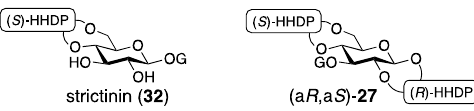
Figure 16. The structure of strictinin ( 32 ) and of a candidate (a R ,a S )- 27 for revised roxbin B.